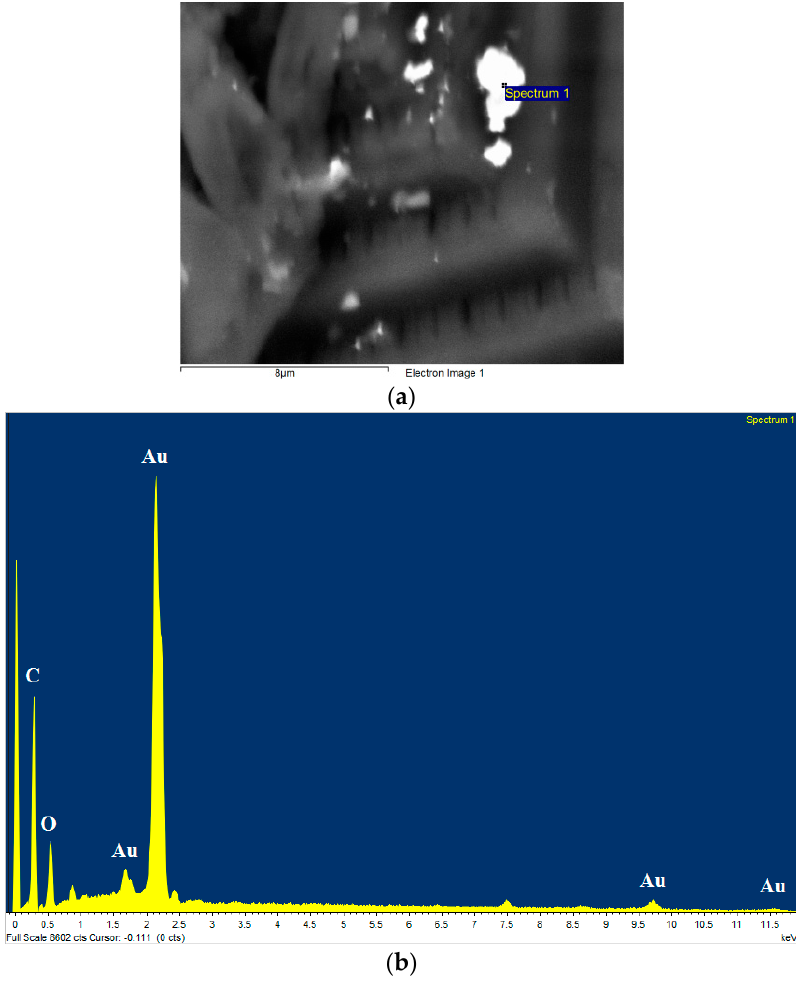
Figure 8. ( a ) A backscattered electron (BSE) image showing the presence of suspected gold particles at the surface of a structure fabricated using Formulation 6; ( b ) an energy dispersive X-ray spectroscopy (EDX) spectrum of the particle located at Position 1 in ( a ), indicating the presence of elemental gold.